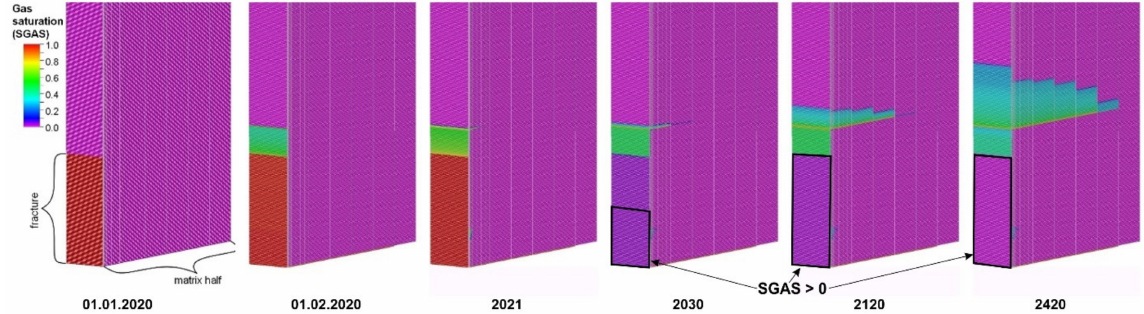
Figure 28. CO 2 migration in the fracture and pores of the overburden rocks. Distribution of CO 2 saturation as a function of time. Model III, Sub-scenario